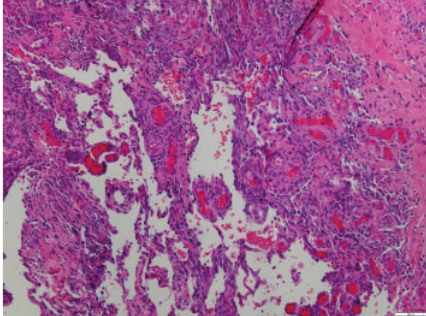
Figure 3: High power view showing multiple vascular sinuses lined by tufts of neoplastic endothelial cells.